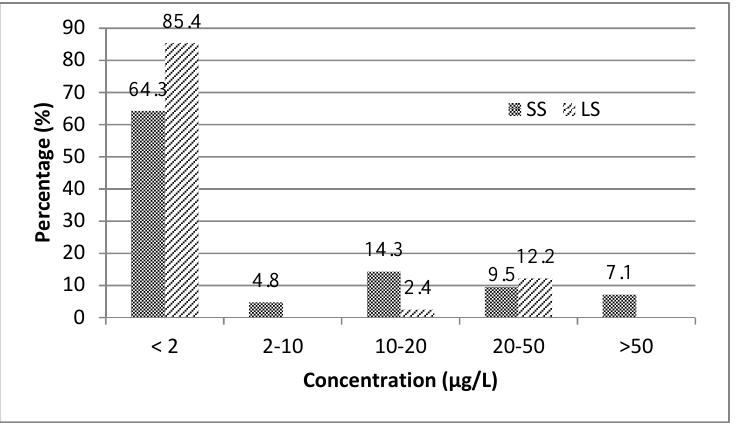
Figure 2. Relative frequency distribution (%) of deoxynivalenol in small- (SS, n = 42) and large-scale (LS, n = 41) brewed beer.